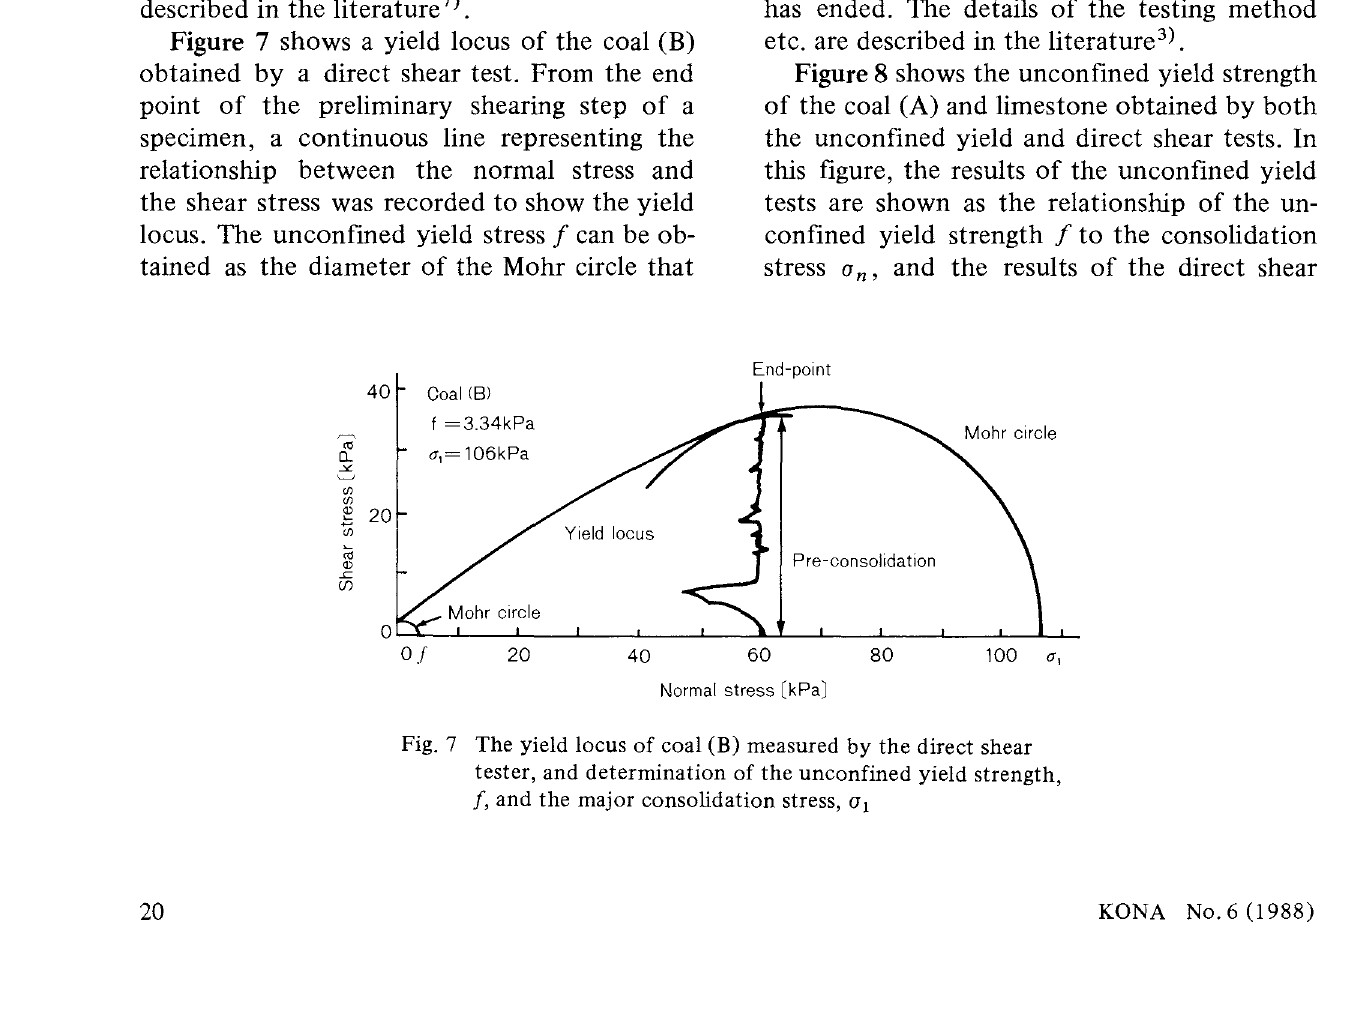
Fig. 8 A comparison of the unconfined yield strength of coal (A) and limestone obtained from the unconfined yield tests and the direct shear tests passes through the origin of the coordinates and meets the yield locus at one point. The major consolidation stress a is shown by the 1 Mohr circle which meets the yield locus at the